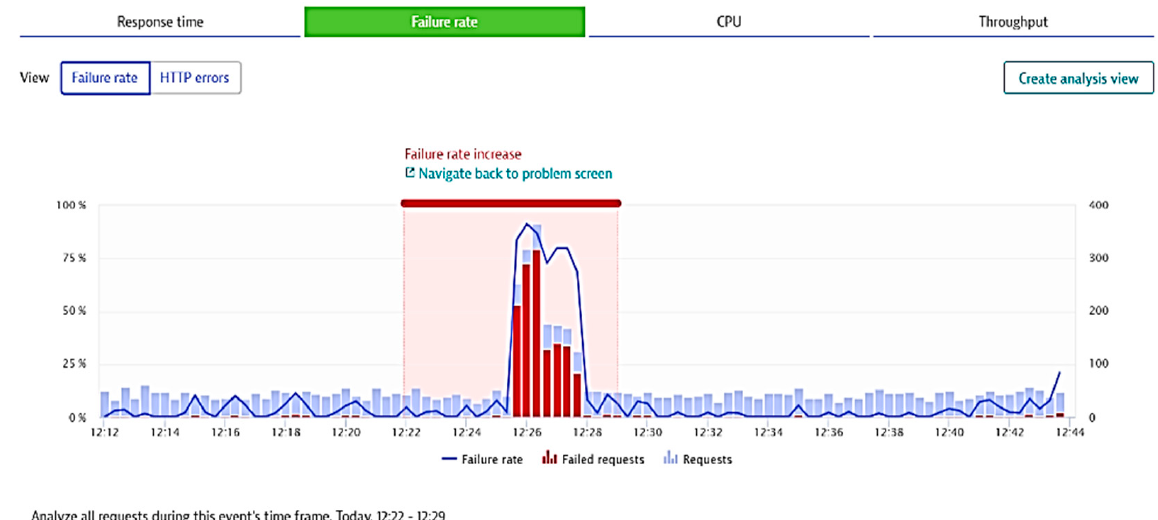
Figure 2. Caption of a failure rate increase detection as shown by Davis AI.